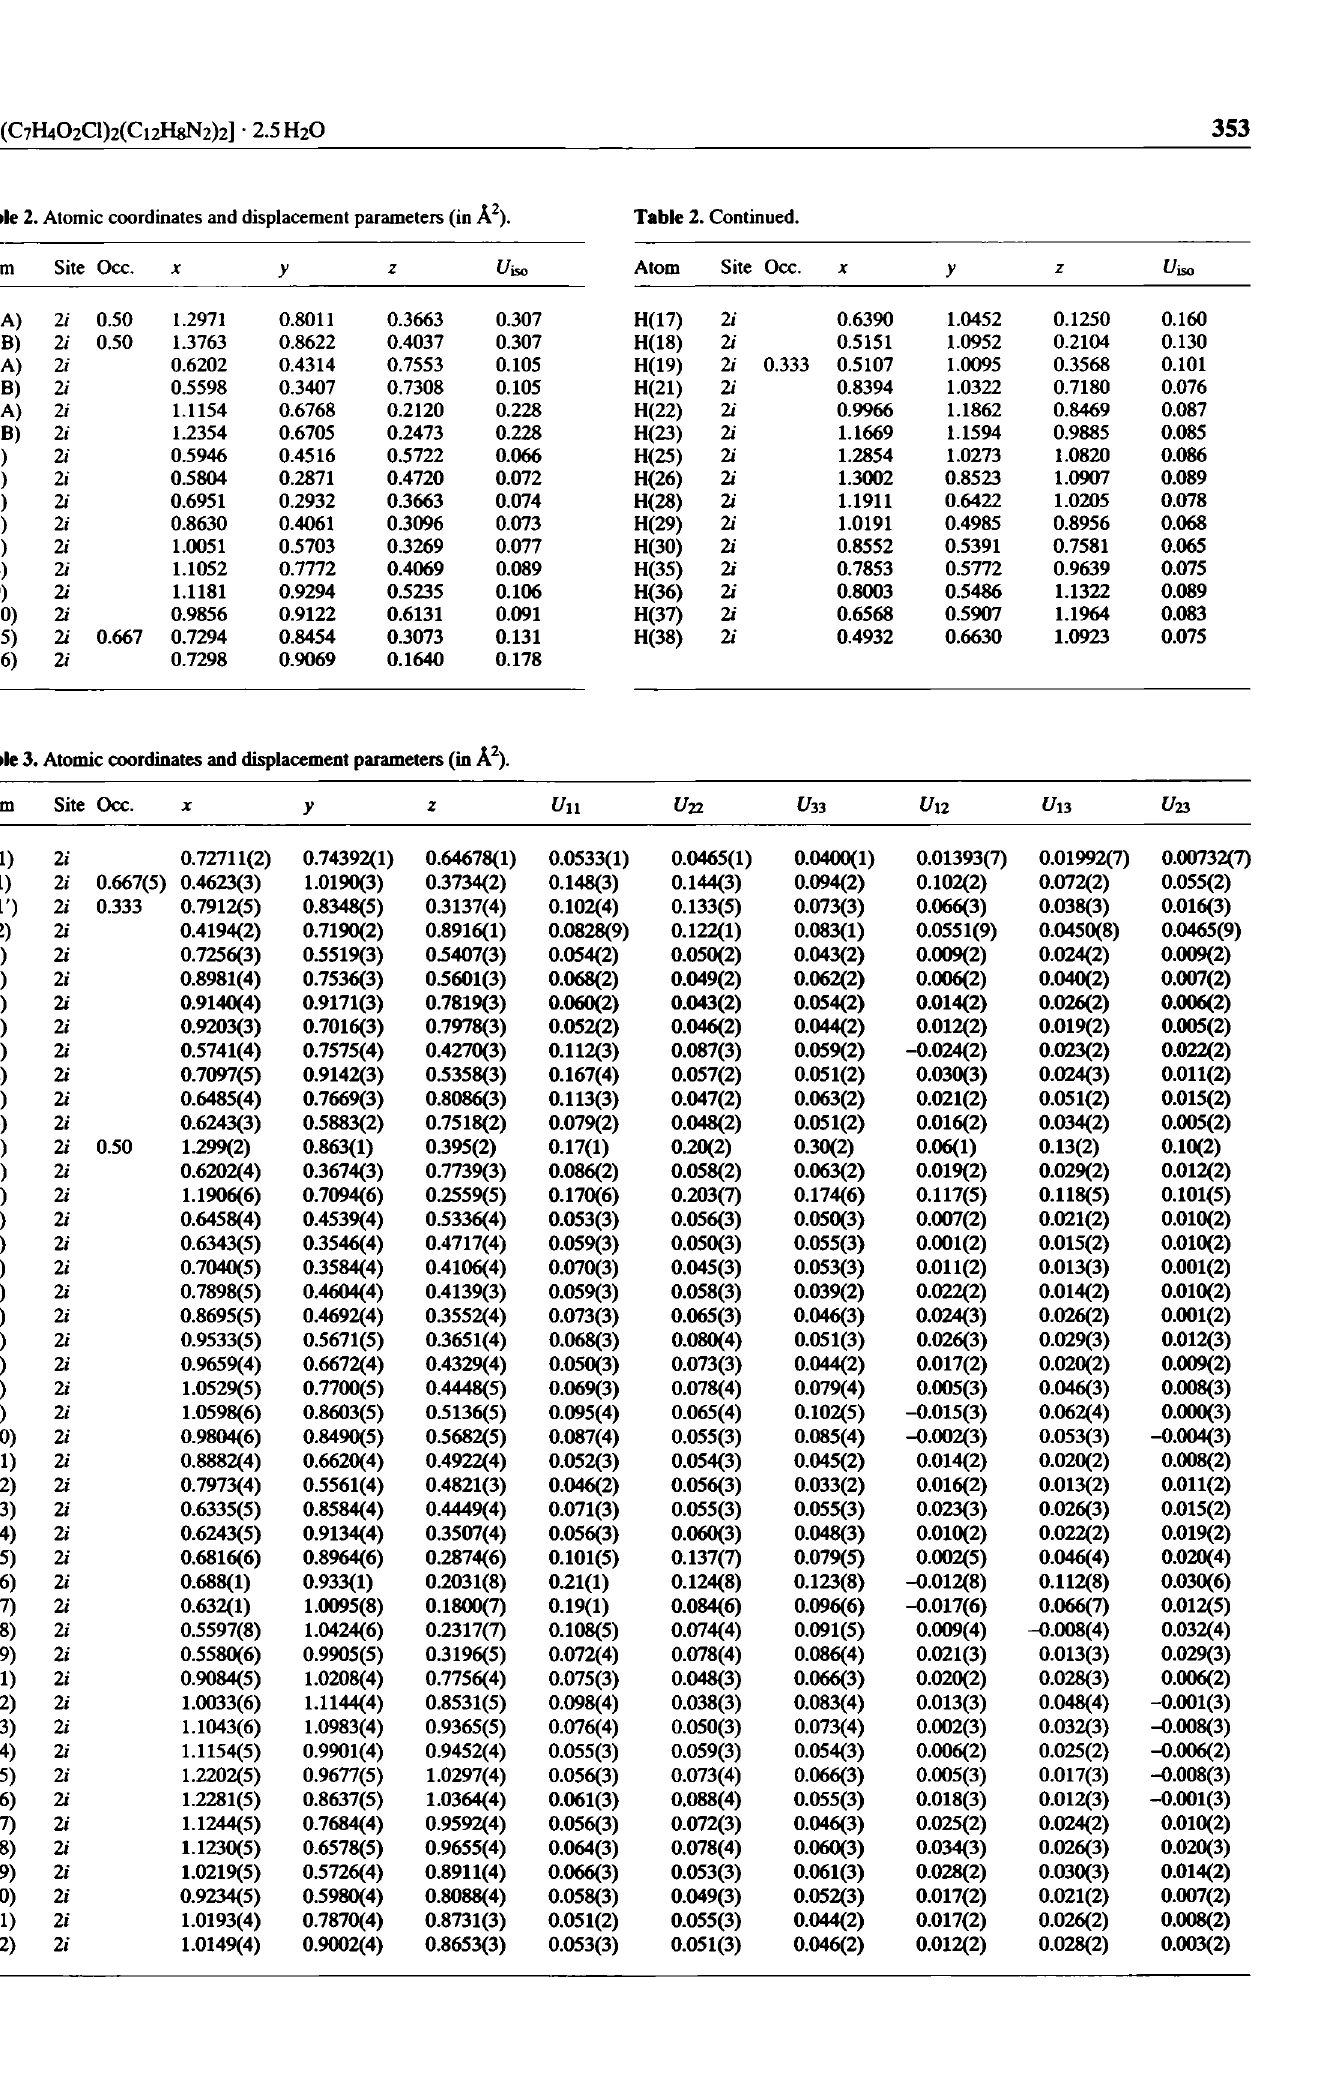
Table 3. Atomic coordinates and displacement parameters (in Ä 2